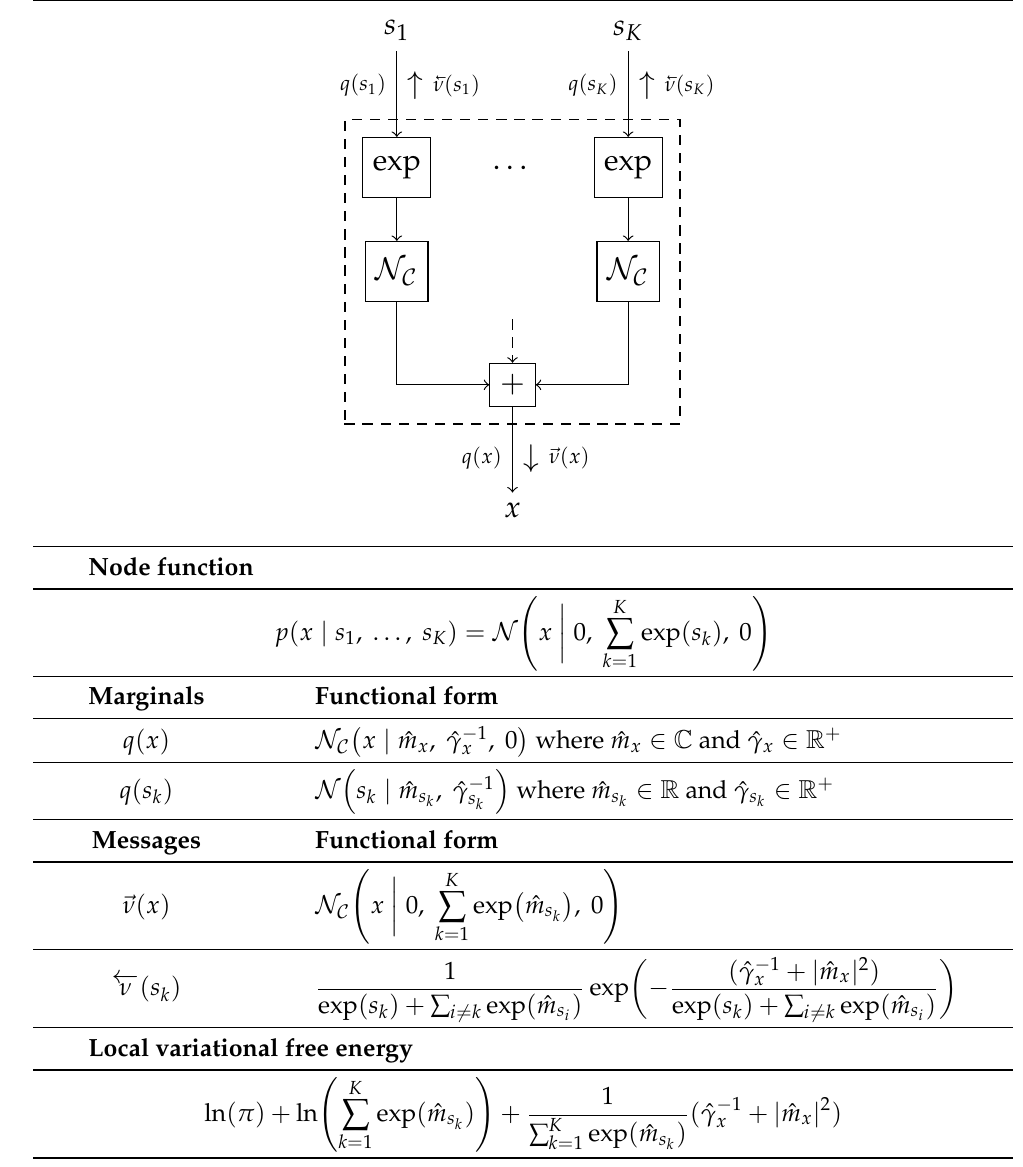
Table 2. Table containing (a) the Forney-style factor graph representation of the Gaussian scale sum node. (b) The likelihood function corresponding to the Gaussian scale sum node. (c) An overview of the chosen approximate posterior distributions. Here the ˆ accent refers to the parameters of these distributions. (d) The derived variational messages for the Gaussian scale sum node. (e) The derived local variational free energy. All derivations are available at https://github.com/biaslab/ SituatedSoundscaping, accessed on 1 July 2021. Factor graph for the Gaussian scale sum node